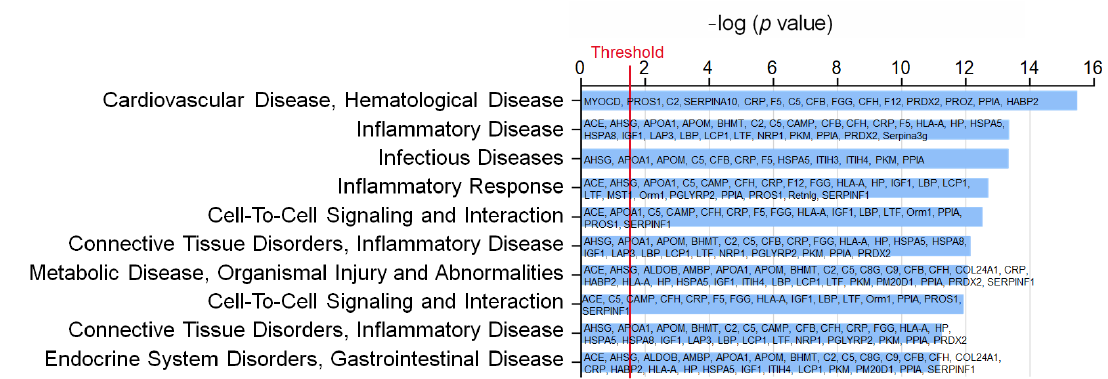
Figure 2. Effects of exercise on the biofunction pathway regulated by proteins between WD and WD EX groups. The 10 most different biofunction pathways are presented and ranked by significant differences between groups. The vertical line indicates the threshold at p < 0.05.